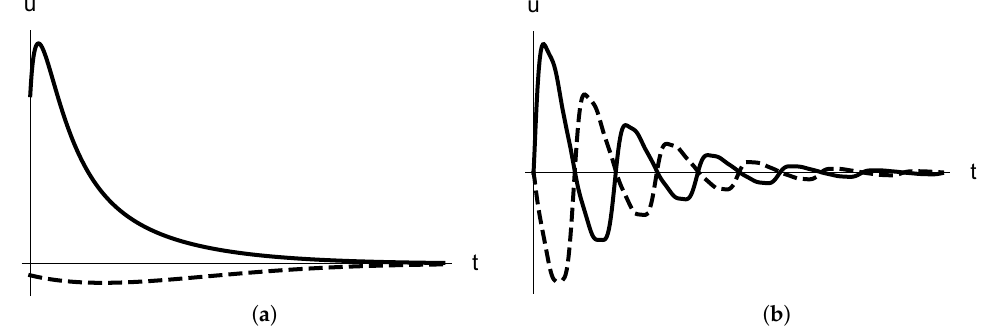
Figure 4. Displacements of the irradiated boundary x = 0 (solid) and the opposite boundary x = l (dashed), calculated within ( a ) the proposed solution (33) and ( b )